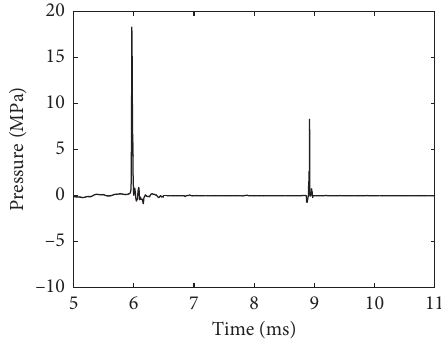
Figure 9: Pressure-time diagram.